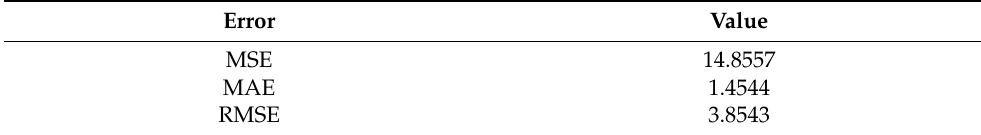
( a ) ( b ) Figure 17. ( a ) Error and ( b ) relative error of the prediction of solar radiation using the ARMA (4,4) model. Table 8. MSE, MAE, and RMSE of the prediction of solar radiation using the ARMA (4,4) model. Error